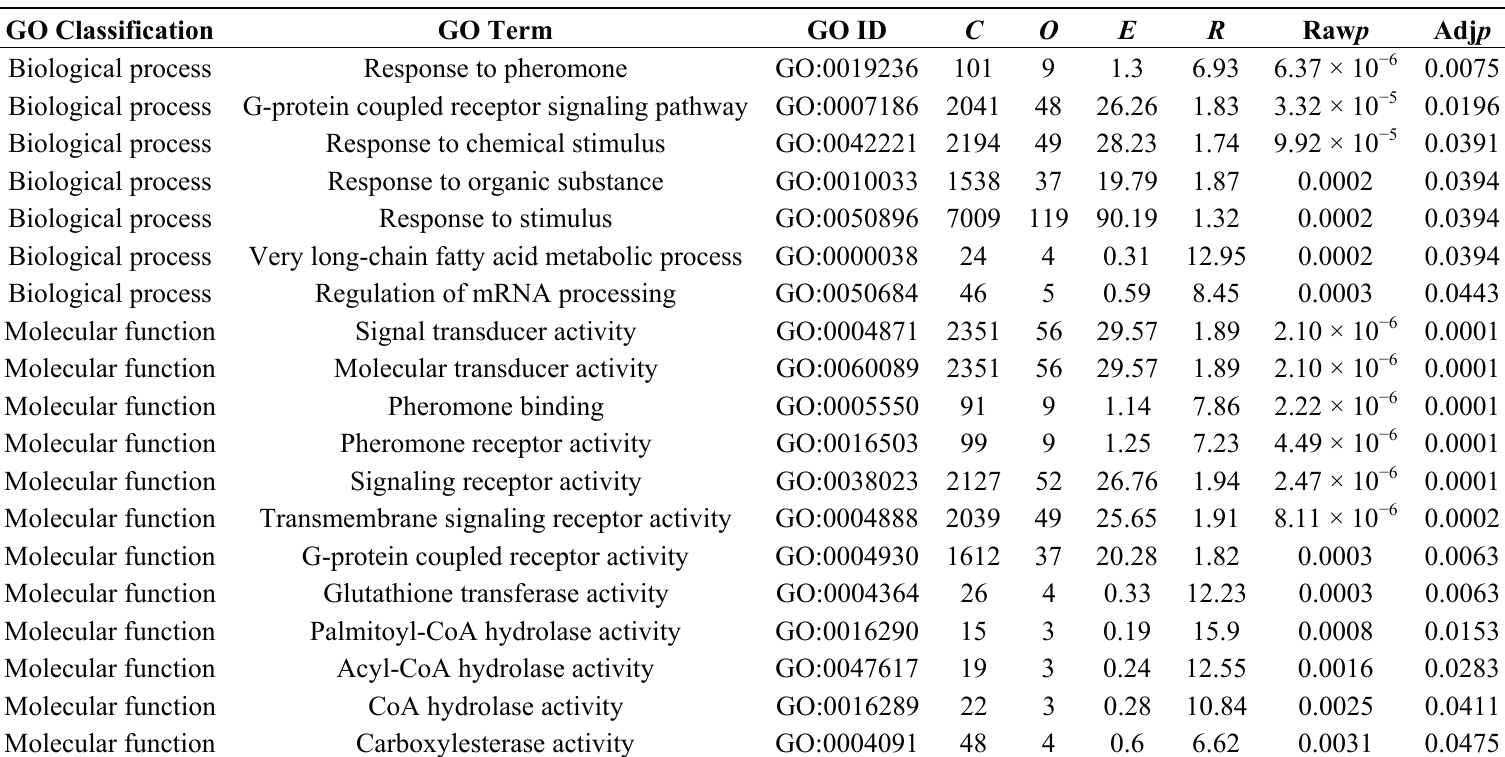
Table 2. Gene ontology (GO) groups with differentially expressed genes in the high-fat diet offspring ( p < 0.05). GO Classification GO Term Biological process